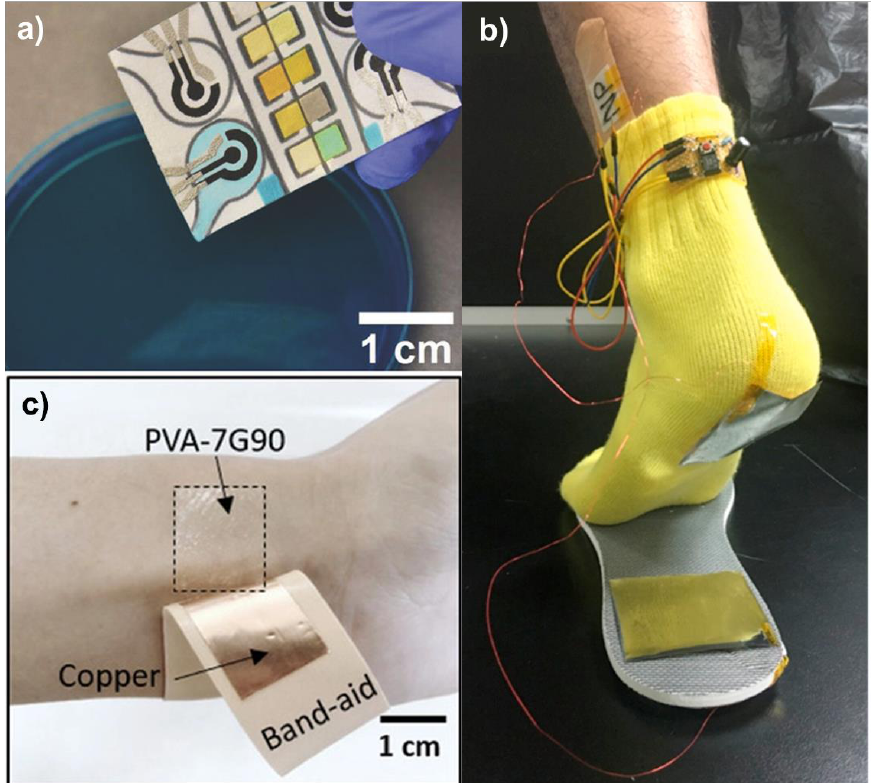
Figure 5. Example of wearable sensors, and where sample collection has been streamlined for simplicity. ( a ) Here the TENG-powered electrochemical sensor is dipped into the analyte solution and automatically imbibes the liquid, avoiding the requirement for pipettes, figure adapted from Pal et al. [21]. ( b ) Here a self-powered sensor is combined onto a bandage which can provide a comfortable, wearable experience for sensing lactate in-situ, figure adapted from Chen et [56]. ( c ) Here a wearable PVA film is used to power the sensing of cardiovascular information, figure adapted from Wang et al.